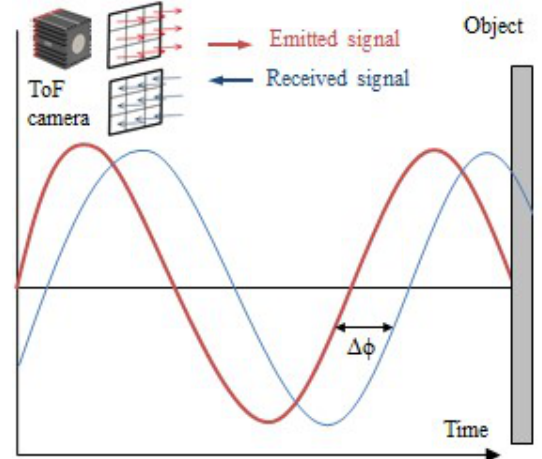
Figure 2. ToF camera phase-shift